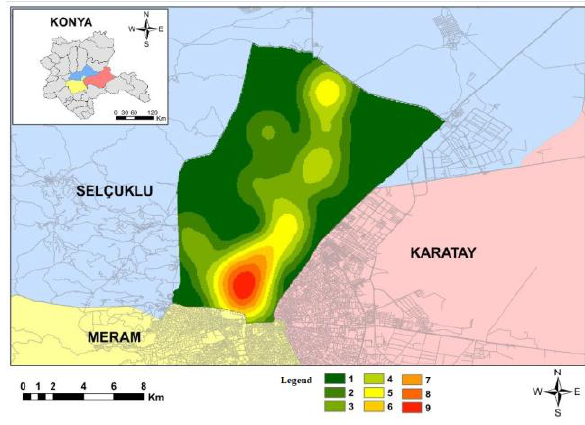
Figure 8. Market places density analysis